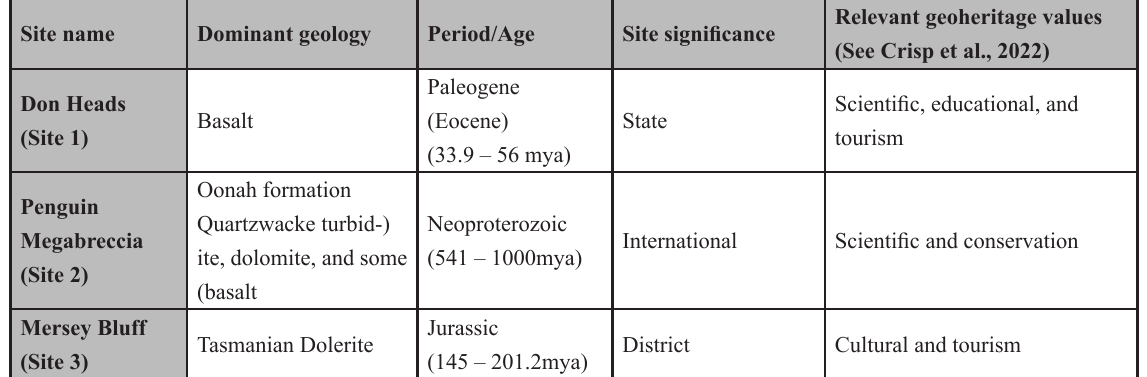
Table 1. Dominant geological type, age, geoheritage significance and relevant values from case study coastal geo- conservation sites considered in this